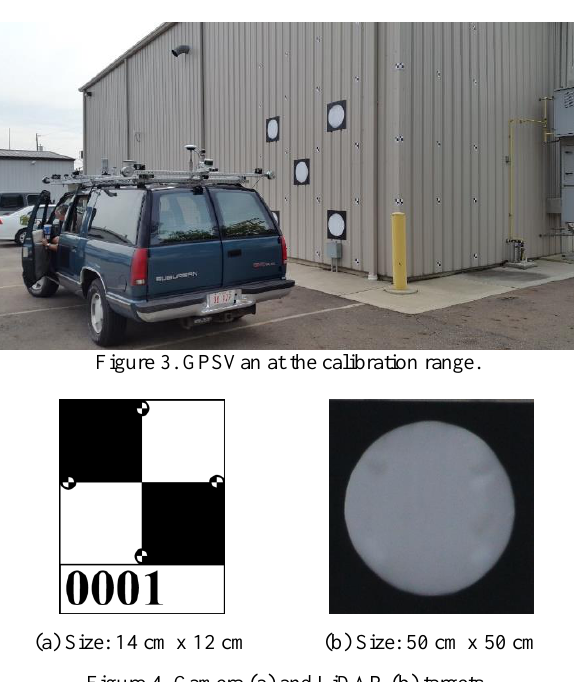
Figure 4. Camera (a) and LiDAR (b)